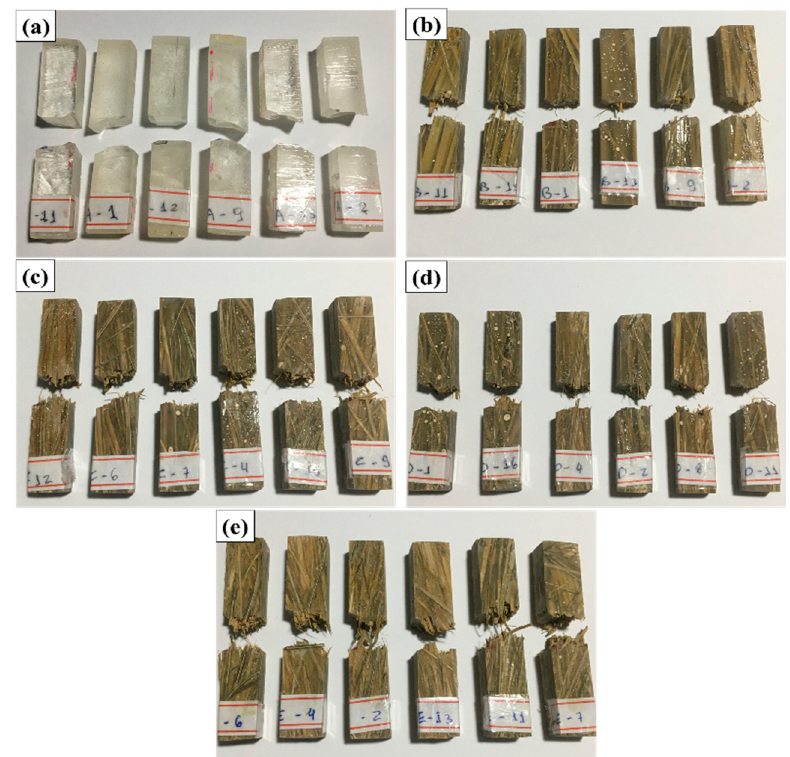
Figure 10. Fractured specimens after the Izod test: ( a ) 0, ( b ) 10, ( c ) 20, ( d ) 30, and ( e ) 40 vol% of carnauba fibers. Table 4. Variance analysis of average impact energies obtained for reinforced epoxy matrix composites with percentages of carnauba fibers from 0 to 40 vol%. Sum of Variation Causes DF Mean Square F(calc.) Squares